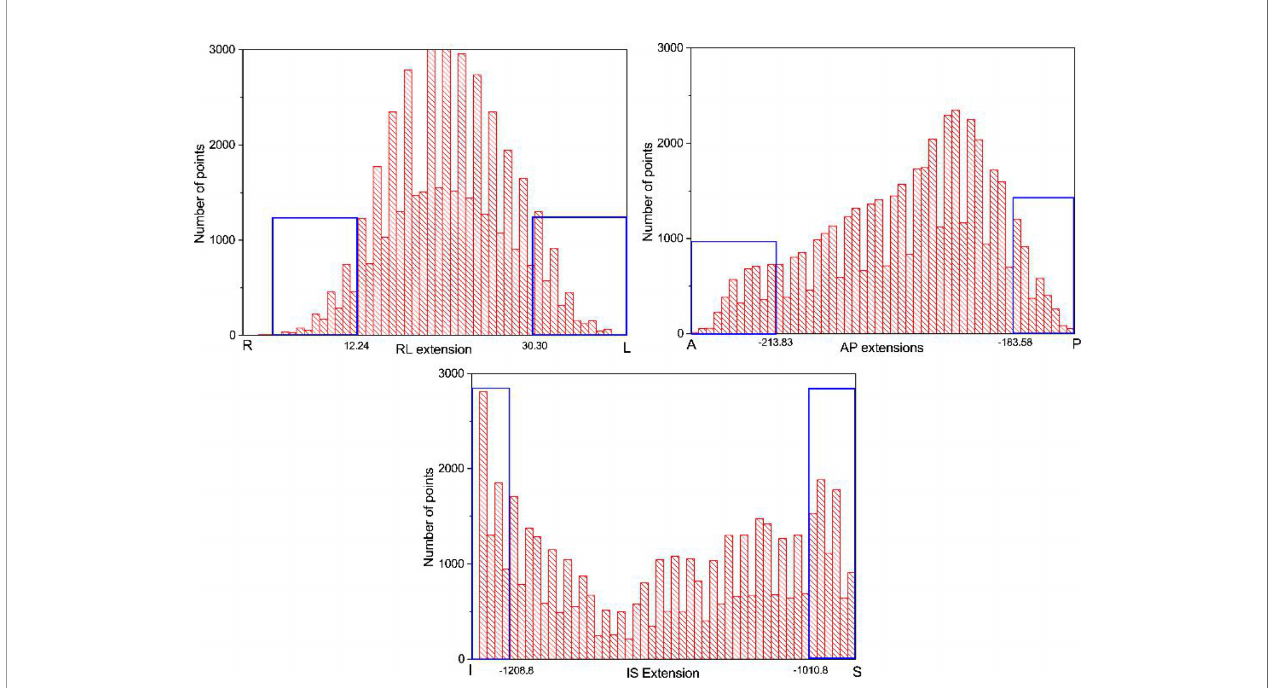
FIGURE 1 | The histograms used to select the most inferior/superior, anterior/posterior, and right/left points. The voxel points in the blue frame are the extreme